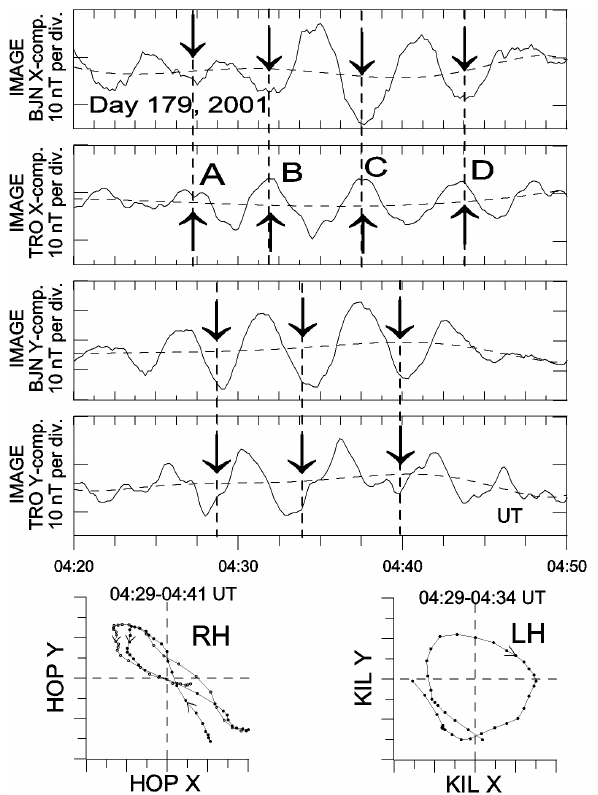
Fig. 1. X and Y component magnetograms, from two successive in latitude (i.e. BJN and TRO) ground stations of the IMAGE ar- ray, for the event of day 179, 2001. Between the two stations the X component traces show waves in anti-phase, whereas the Y compo- nents vary in-phase. The HOP (KIL) station, which has a latitude higher (lower) than that of the BJN (TRO) station, shows right-hand (left-hand) polarized waves.